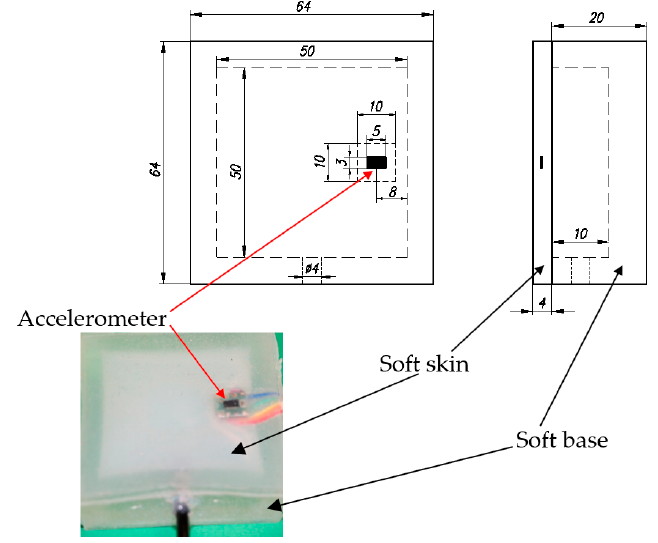
Figure 2. Dimension and photograph of fabricated tactile sensing system.